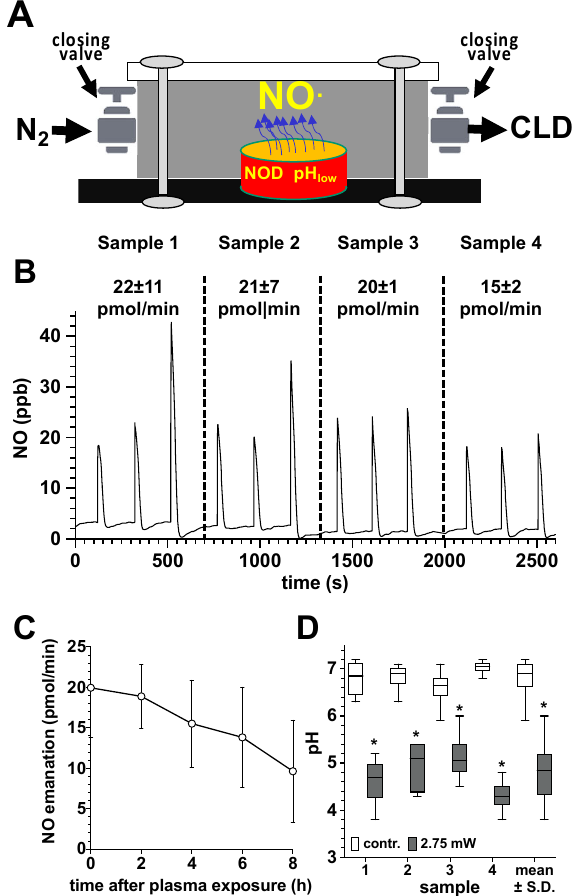
Figure 3. Quantification of NO release from plasma-treated human bone samples. ( A ), sketch of the experimental setup for quantifying the NO release of plasma-exposed bone tissue. DBD plasma- treated human bone samples (10 min at 275 mW power dissipation in the discharge) of the femur neck (500–800 mg) were transferred to a hermetically sealed chamber (35.2 cm 3 ), flushed with nitrogen to remove oxygen immediately after the plasma exposure. NO liberated from the bone samples was accumulated in the chamber for 120 s and the NO content was quantified by flushing the gas contents of the chamber into the CLD analyzer. ( B ), NO release (pmol/min) from the treated bone tissue (mean values ± S.D. of three measurements (triplicates) of each of the four samples (samples 1–4). ( C ), Characterization of the NO emanation (pmol/min) from the tissue of the four plasma-treated bone samples at different time points after the plasma treatment. ( D ), pH values of the treated surface of the four plasma treated bone samples immediately after plasma exposure, as detected by using a flat membrane pH electrode. *, p < 0.05 as compared to the control samples.